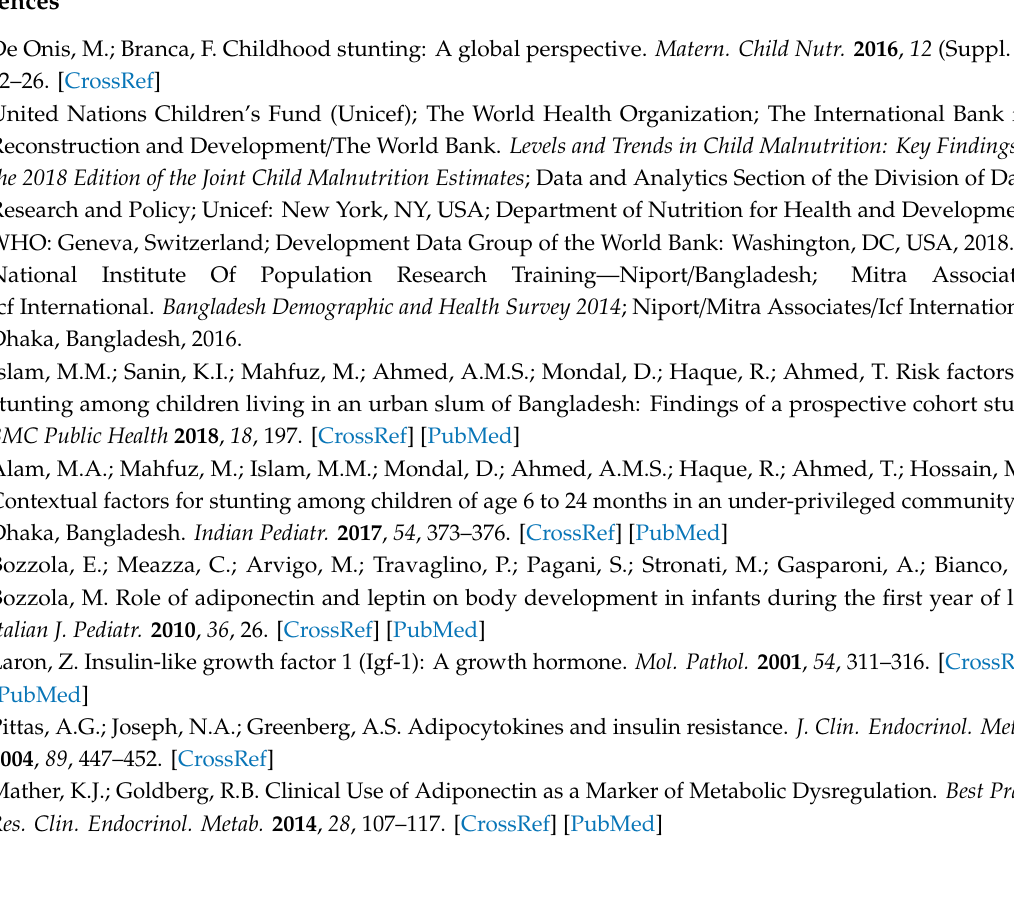
Table S1: Spearman correlation between di ff erent biomarkers at enrolment in stunted children; Table S2: Spearman correlation between di ff erent biomarkers at 6-months post-enrolment in stunted children; Table S3: Spearman correlation between di ff erent biomarkers at enrolment in control children; Table S4: Spearman correlation between di ff erent biomarkers at six months post-enrolment in control